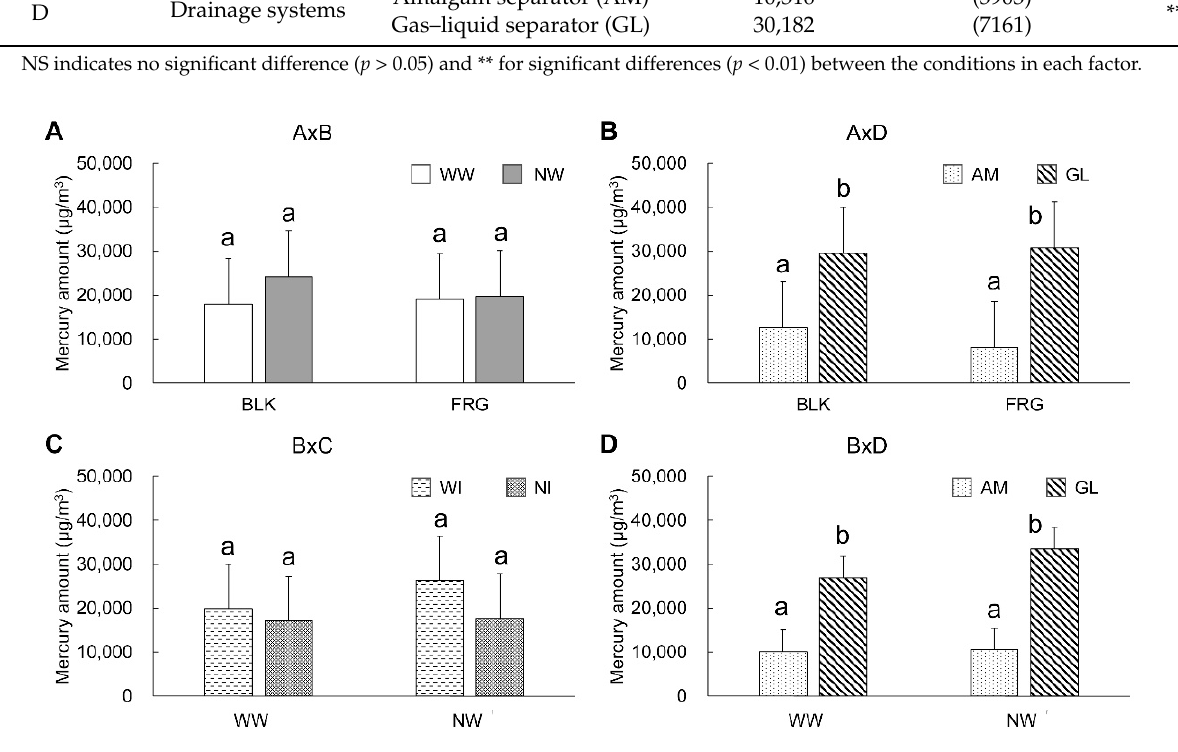
Figure 4. Mercury amounts in the oral rinse water. Error bar indicates standard deviation. Same letter designation indicates nonsignificant difference ( p > 0.05). ( A ) Interaction of removal methods (block system: BLK, fragment system: FRG) with absence of cooling water (with cooling water: WW, no cooling water: NW), ( B ) Interaction of removal methods with difference of drainage system (amalgam separator: AM, gas-liquid separator: GL), ( C ) Interaction of absence of cooling water with absence of intraoral suction (with intraoral suction: WI, no intraoral suction: NI), ( D ) Interaction of absence of cooling water with difference of drainage